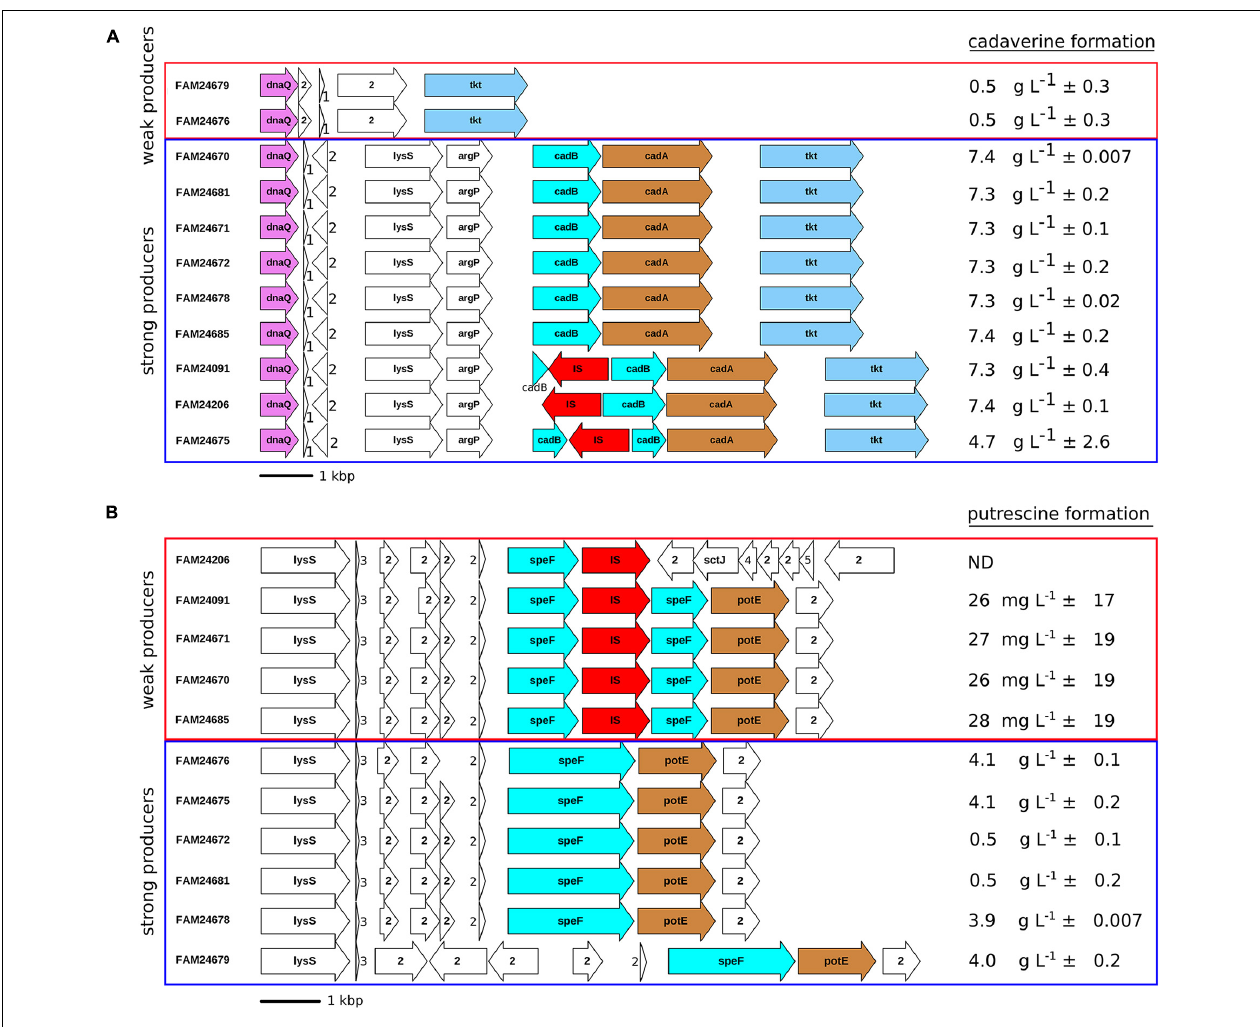
FIGURE 3 | Genetic organization of loci containing the genes involved in (A) cadaverine formation and (B) putrescine formation. Arrows indicate open reading frames. DnaQ , DNA polymerase III subunit epsilon; tkt , transketolase; lysS , lysine-tRNA ligase; argP , HTH-transcriptional regulator; cadB , cadaverine-lysine antiporter; cadA , lysine decarboxylase; IS, insertion sequence; speF , ornithine decarboxylase; potE , putrescine-ornithine antiporter; sctJ , type III secretion inner membrane ring lipoprotein, 1: tRNA Asp , 2: hypothetical protein, 3: tRNA Gly , 4( sctI ): type III secretion system inner rod subunit, 5 ( sctF ): type III secretion system needle filament subunit. The mean ± standard deviation of biogenic amine formation of two replicates determined by HPLC is shown (mg of biogenic amines per L broth). Rectangles mark strong (blue) and weak (red) biogenic amine producers. Some orthologs are colored in order to increase readability. ND: below limit of